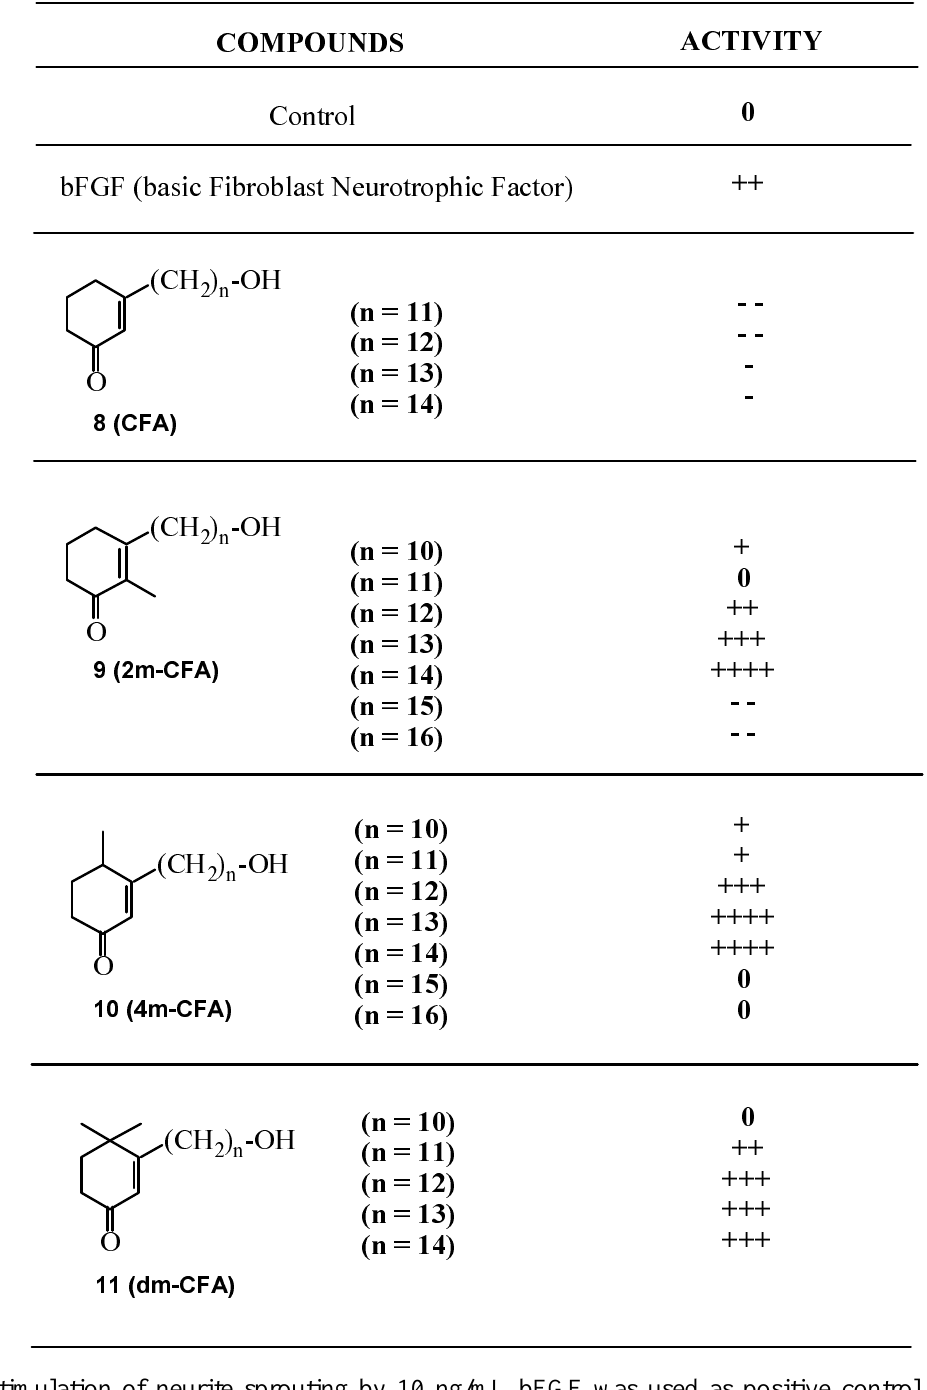
Table 2. Structure/activity relationships of the CFA series 8 , 9 , 10 , and 11 according to their neuritogenic effect in cultured CNS